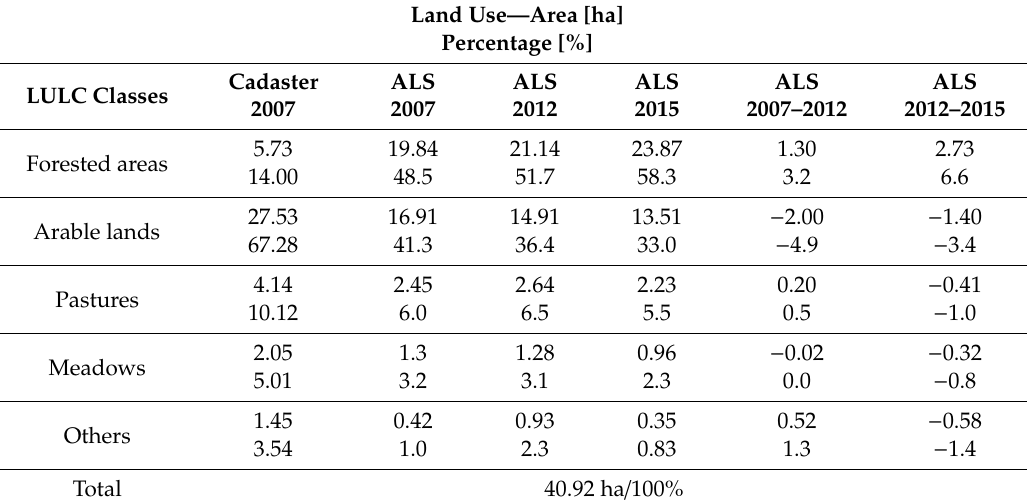
Table1. Landuseclasses—areareceivedbasedonALSdata(2007, 2012, 2015)processing, anddi ff erences from 2007–2012 and 2012–2015.